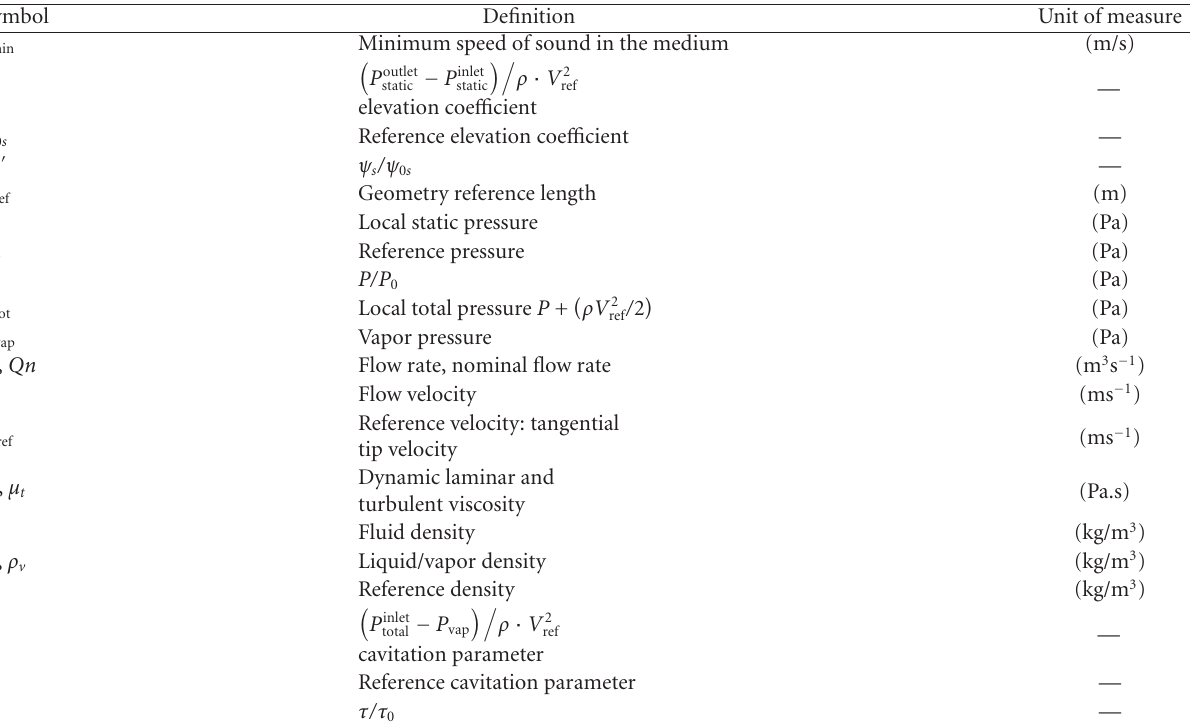
Table 1: Nomenclature.